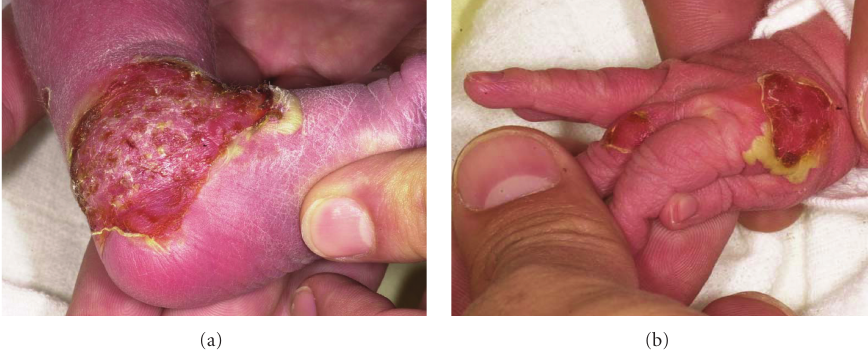
Figure 6: (a) and (b) patient 2: Partially ruptured pustules, resulting in large circumscribed erosions on the right hand and left